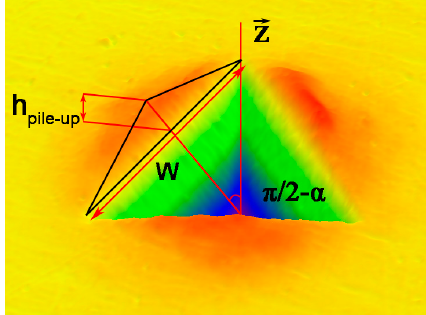
Figure 5. Approximation of the real projected contact area resulting from pile-up formation: the maximum height and width of each pile-up around the imprint are considered to determine the projected area using triangles, and the imprints depict one typical example from the 300 nm Cu mentioned in the text.